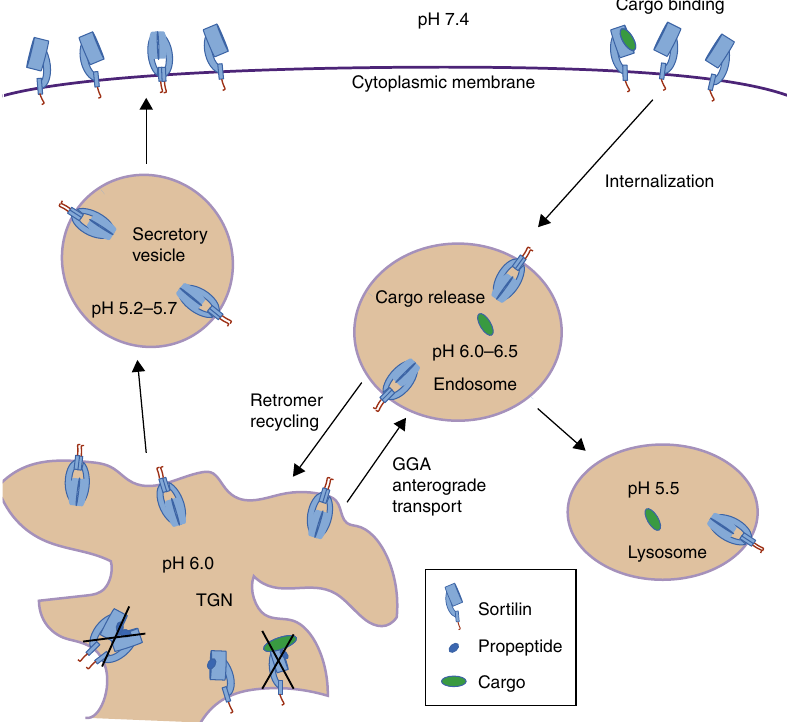
Fig. 8 Proposed role of dimerization for sortilin function. After expression, sortilin is a monomer due to the presence of its propeptide. Once the pH drops in the late TGN, the propeptide is released and sortilin is transported to the cell surface or the endosome as a dimer. At the cell surface, sortilin is in an equilibrium between monomer and dimer, but ligands are bound preferentially to the monomer form. Ligand bound sortilin is internalized. Upon endocytosis, sortilin dimerizes due to the acidi fi cation along the endosomal pathway and thereby releases its ligand. Sortilin dimers may control recycling by the retromer and